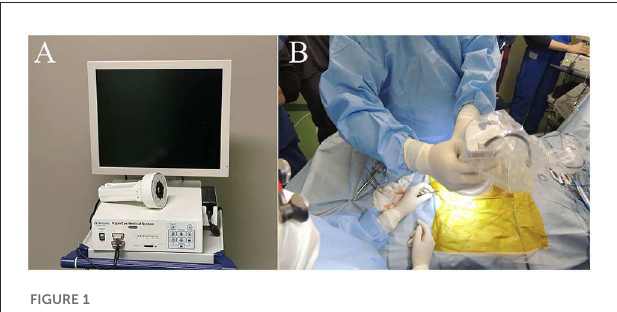
FIGURE1 Near-infrared (NIR) fluorescence imaging using the HyperEye Medical System (HEMS). (A) Real-time NIR fluorescent images of the pulmonary surface observed on the HEMS monitor. (B) Intraoperative observation of a pulmonary fluorescent lesion. The camera unit was equipped with a light-emitting diode (LED) and charge-coupled device